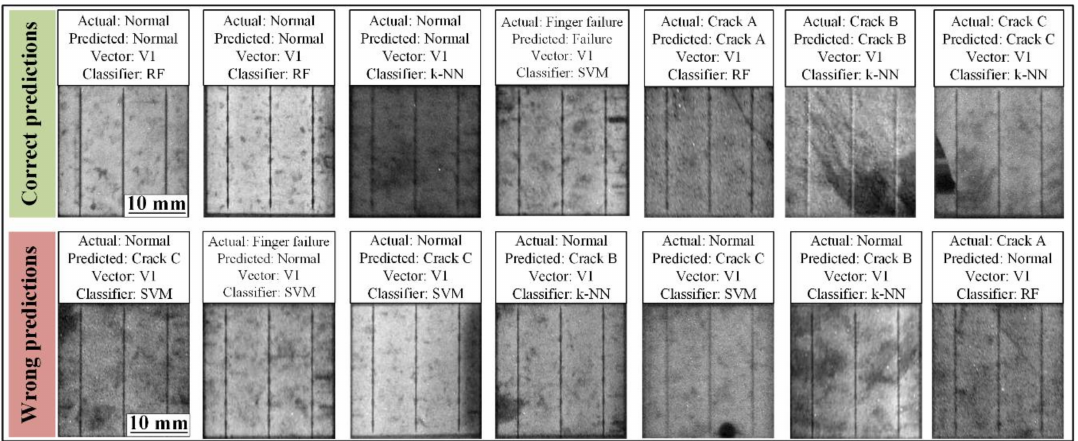
Figure 7. Qualitative evaluation of the correct and wrong predictions based on the proposed algorithms actual and predicted class